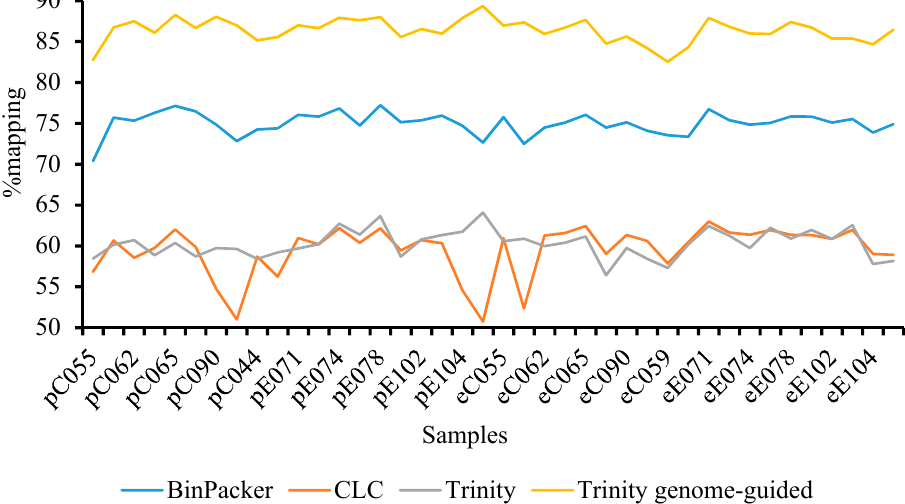
Figure 2. Comparison of pseudoalignment rates between di ff erent assemblies. Kallisto analysis with the FR (Forward / Reverse) strand-specific paired-end pseudoalignment option. Quercus pubescens leaf samples from control (C) and exclusion (E) plots harvested in spring (p) and summer